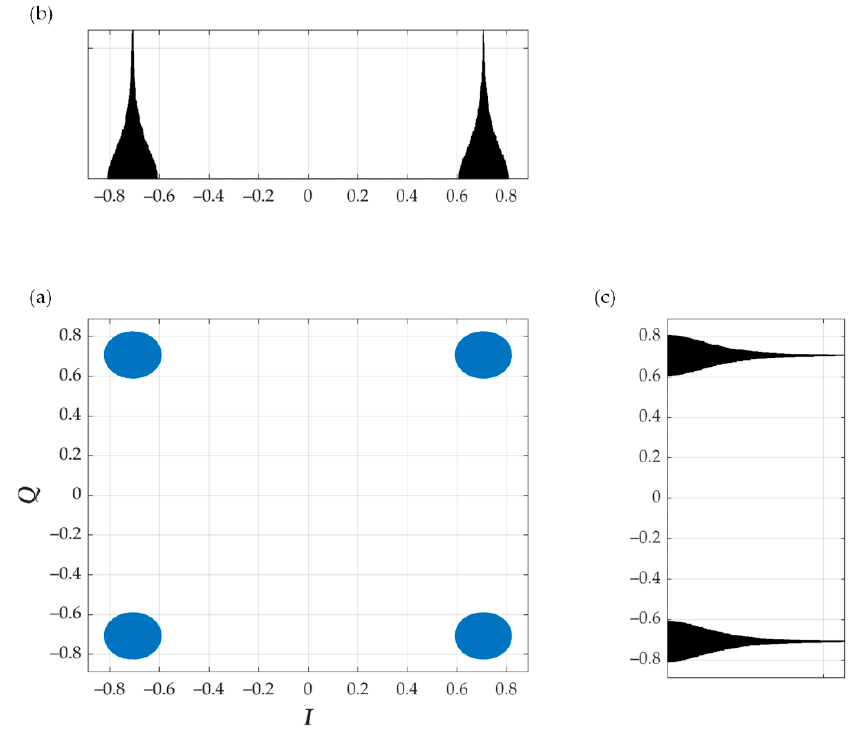
Figure 9 . ( a ) Constellation ( b ) in-phase and ( c ) quadrature histograms for 4 QAM cover and DCM covert channel with M = 4 and for random A m and φ x .